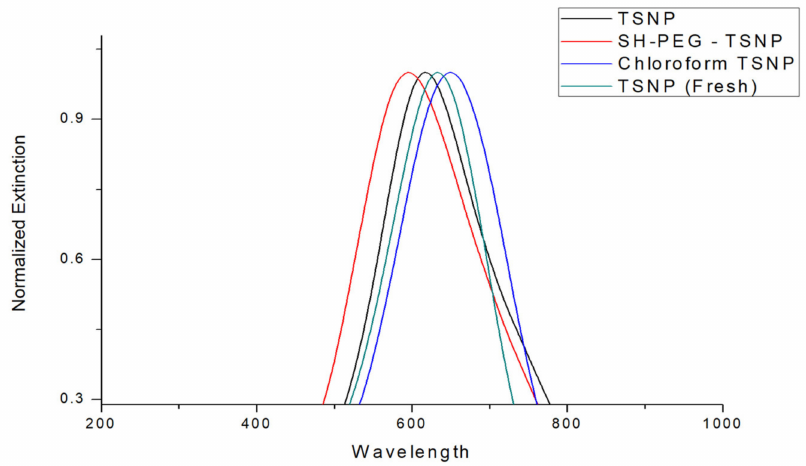
Figure 3. UV-VIS spectra of nonconcentrated TSNPs, concentrated TSNPs, SH-PEG-coated TSNPs, and TSNPs after transfer to chloroform.